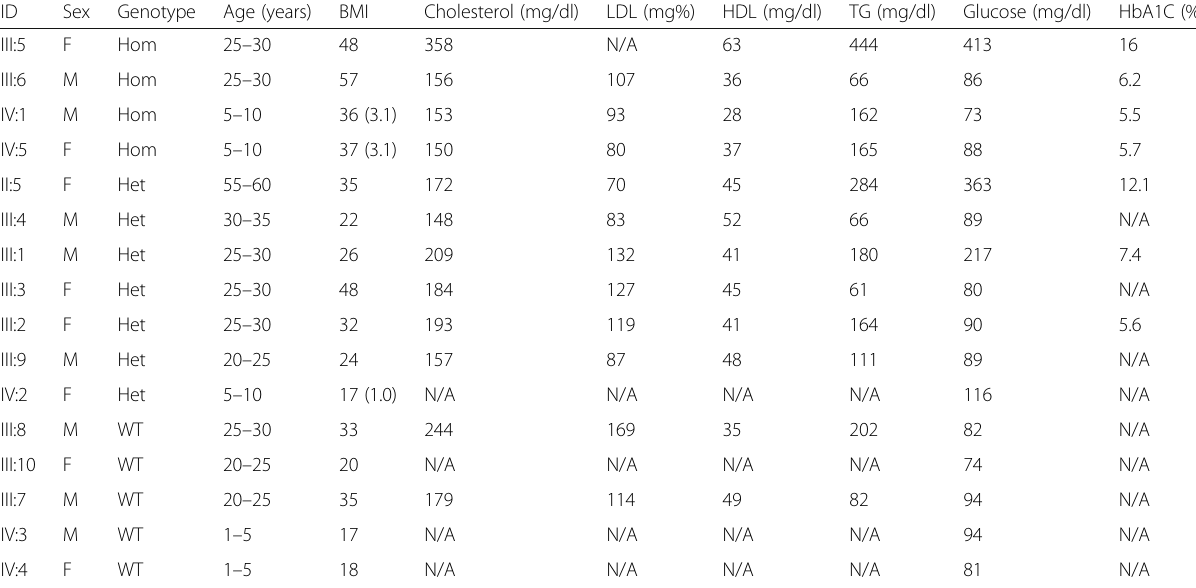
Table 2 Phenotypic delineation of the 16 family members